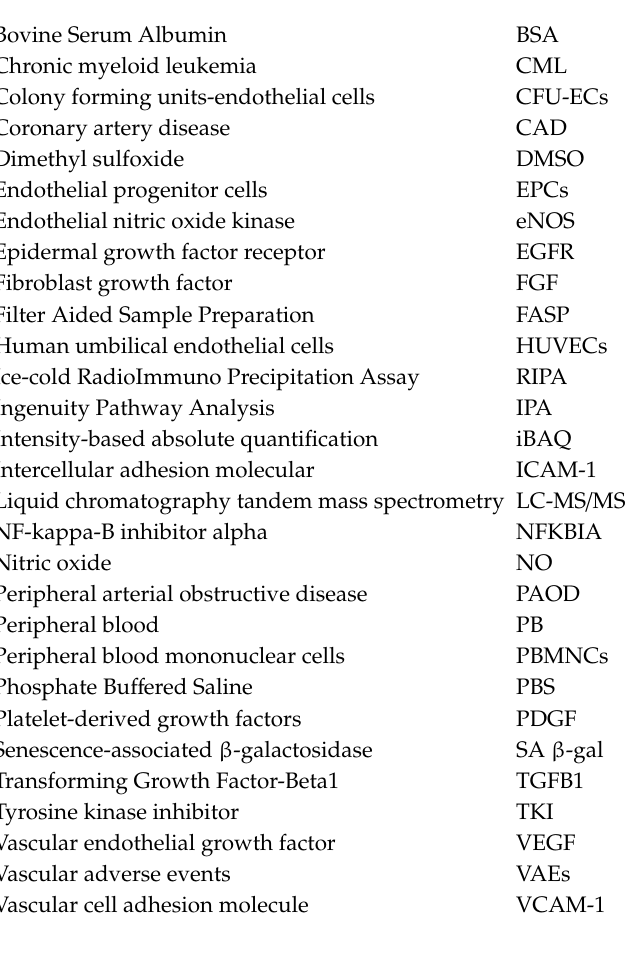
Table S1: list of quantified